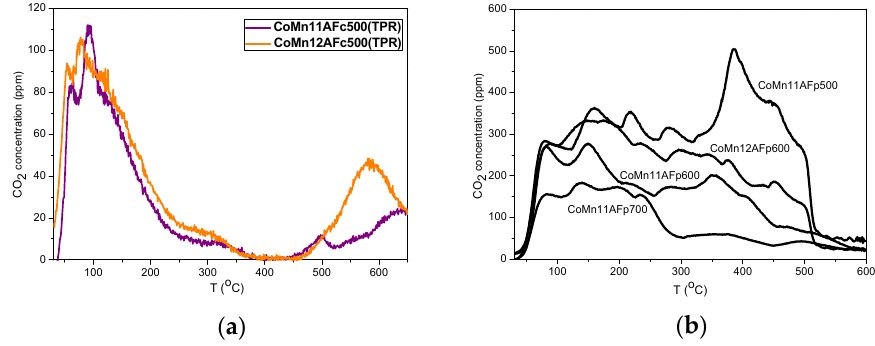
Figure 2. TPD of CO 2 following its adsorption at 25 °C on ( a ) CoMn1 x AFc500 (TPR), x = 1, 2; and ( b ) CoMn11AFpi, i = 500, 600, 700 °C and CoMn12AFp600.